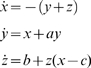
Rössler system: oscillatory patterns and phase-space representation.Rössler system standard values for the constants were set as follows:with a = 0.398, b = 1, c = 3. Left panel: Ordinate: oscillatory behavior of variables x (top) and z (bottom). Abscissa: time. Right panel: phase-space representation of the attractor.